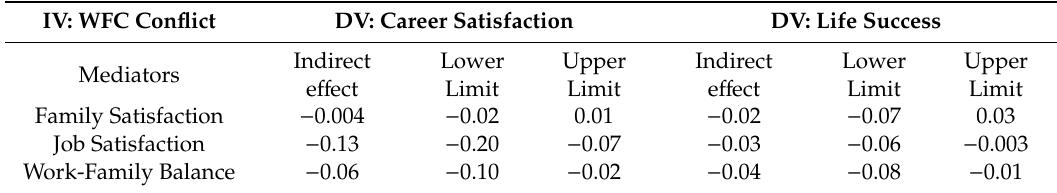
Table 3. Indirect e ff ects for work-family conflict on career satisfaction and life success.